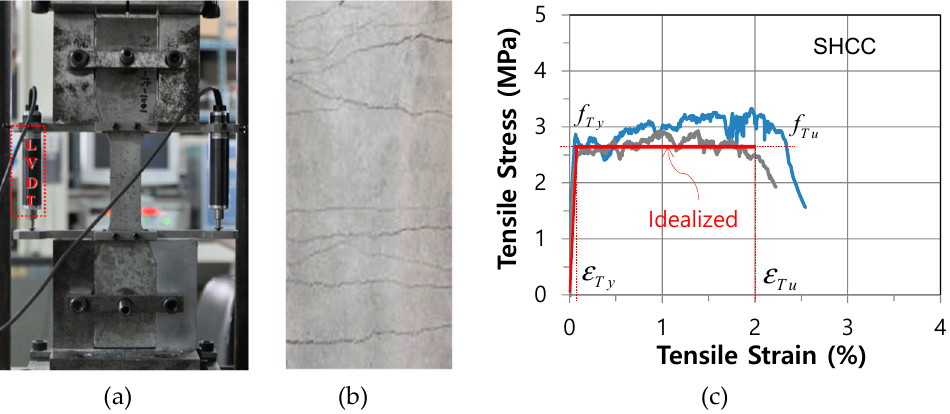
Figure 2. Direct tensile test: ( a ) test setup; ( b ) microcracks; ( c ) post-cracked tensile behavior and model.